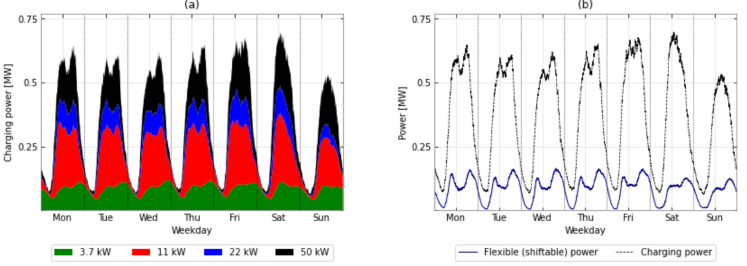
Figure A15. ( a ) User Group E: Charging power profile as a function of the assumed charging power used; ( b ) User Group E: Relation between the charging power profile and the associated flexible (shiftable)